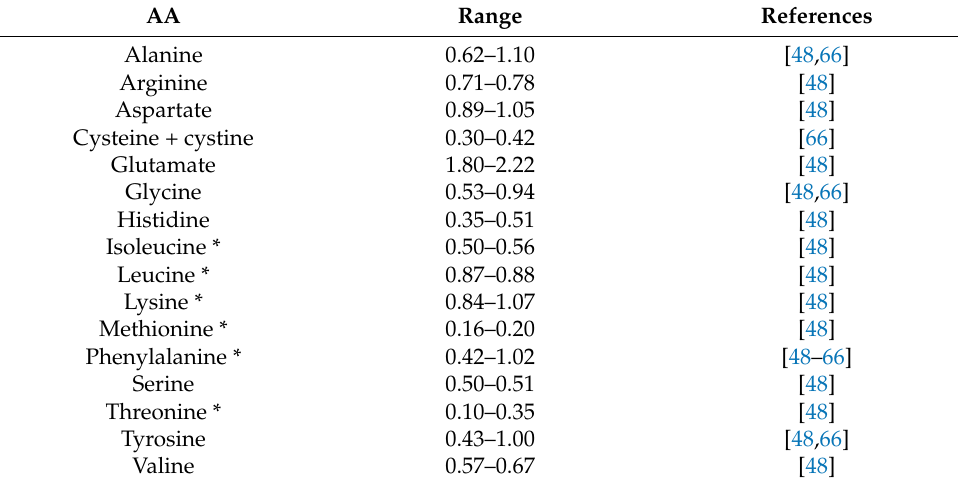
Table 4. Amino acid (AA) content (g/100 g of meat) of river buffalo